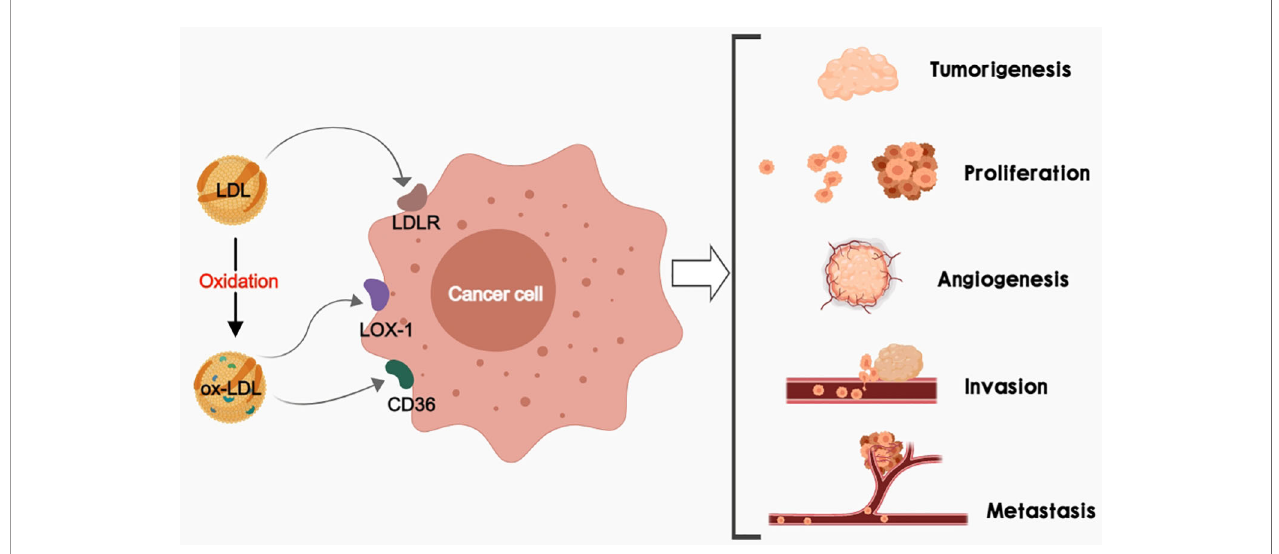
FIGURE 1 | LDL and/or ox-LDL bind to their receptors (LDLR, LOX-1, and CD36) respectively to promote tumorigenesis, cancer cell proliferation, cancer angiogenesis, as well as cancer invasion and